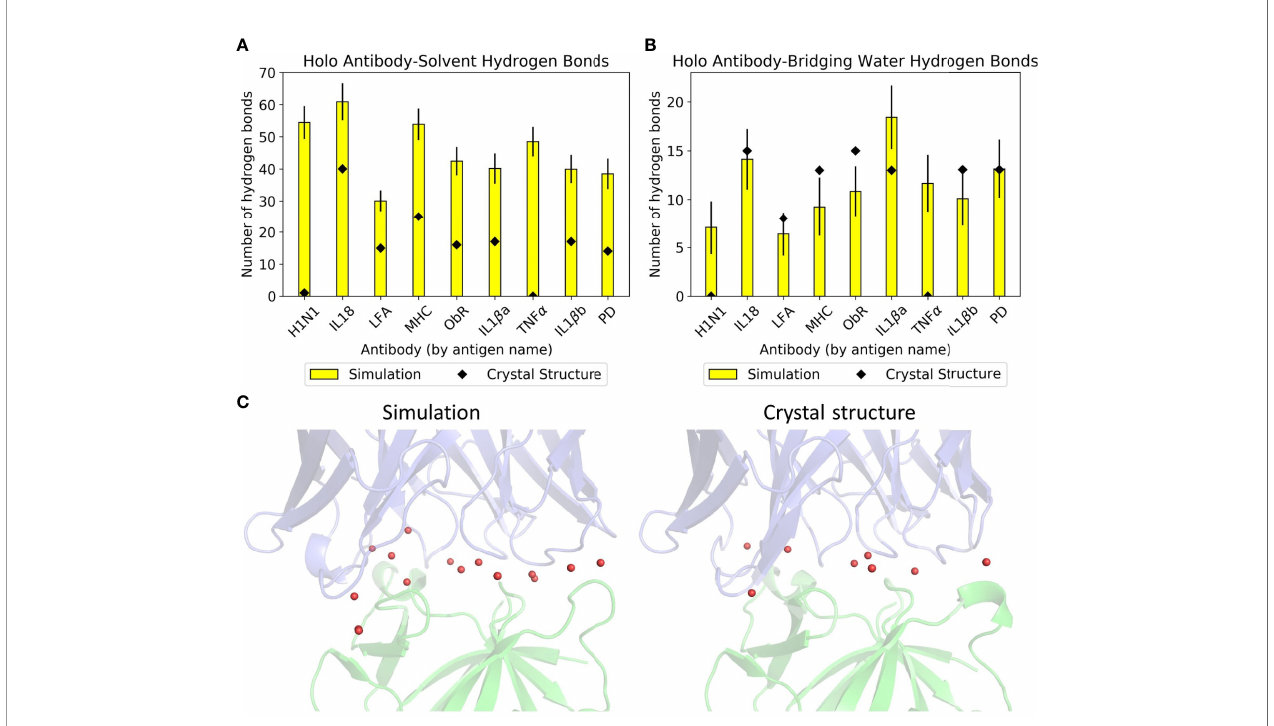
FIGURE 2 | Hydrogen bonding with water in the dataset. Mean numbers of (A) antibody-solvent hydrogen bonds and (B) antibody-bridging water hydrogen bonds formed by the dataset ’ s holo complexes, for both their static crystal structures and when simulated. Error bars for the simulation means are given to one standard deviation. (C) Anti-IL-1 b a ’ s bridging waters (red spheres) in a representative simulation frame (left) and in the crystal structure (right). The Fv is in blue and the antigen in